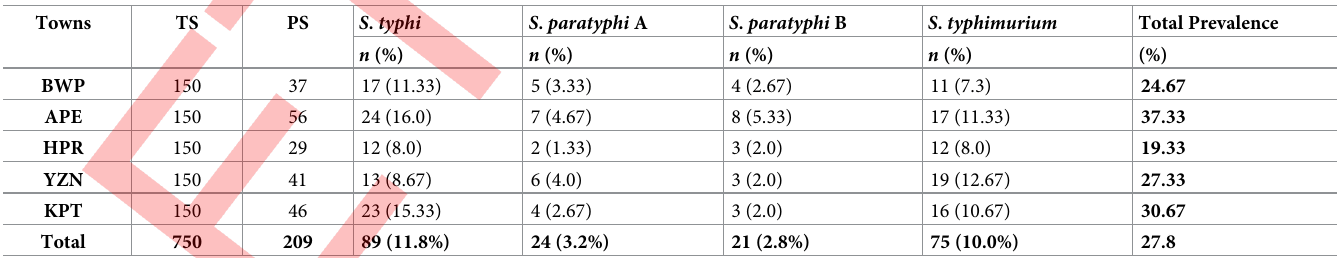
Table 3. Prevalence (%) of Salmonella spp. isolated from raw milk and environment samples in dairy farms from district Bahawalpur . Towns TS PS S .